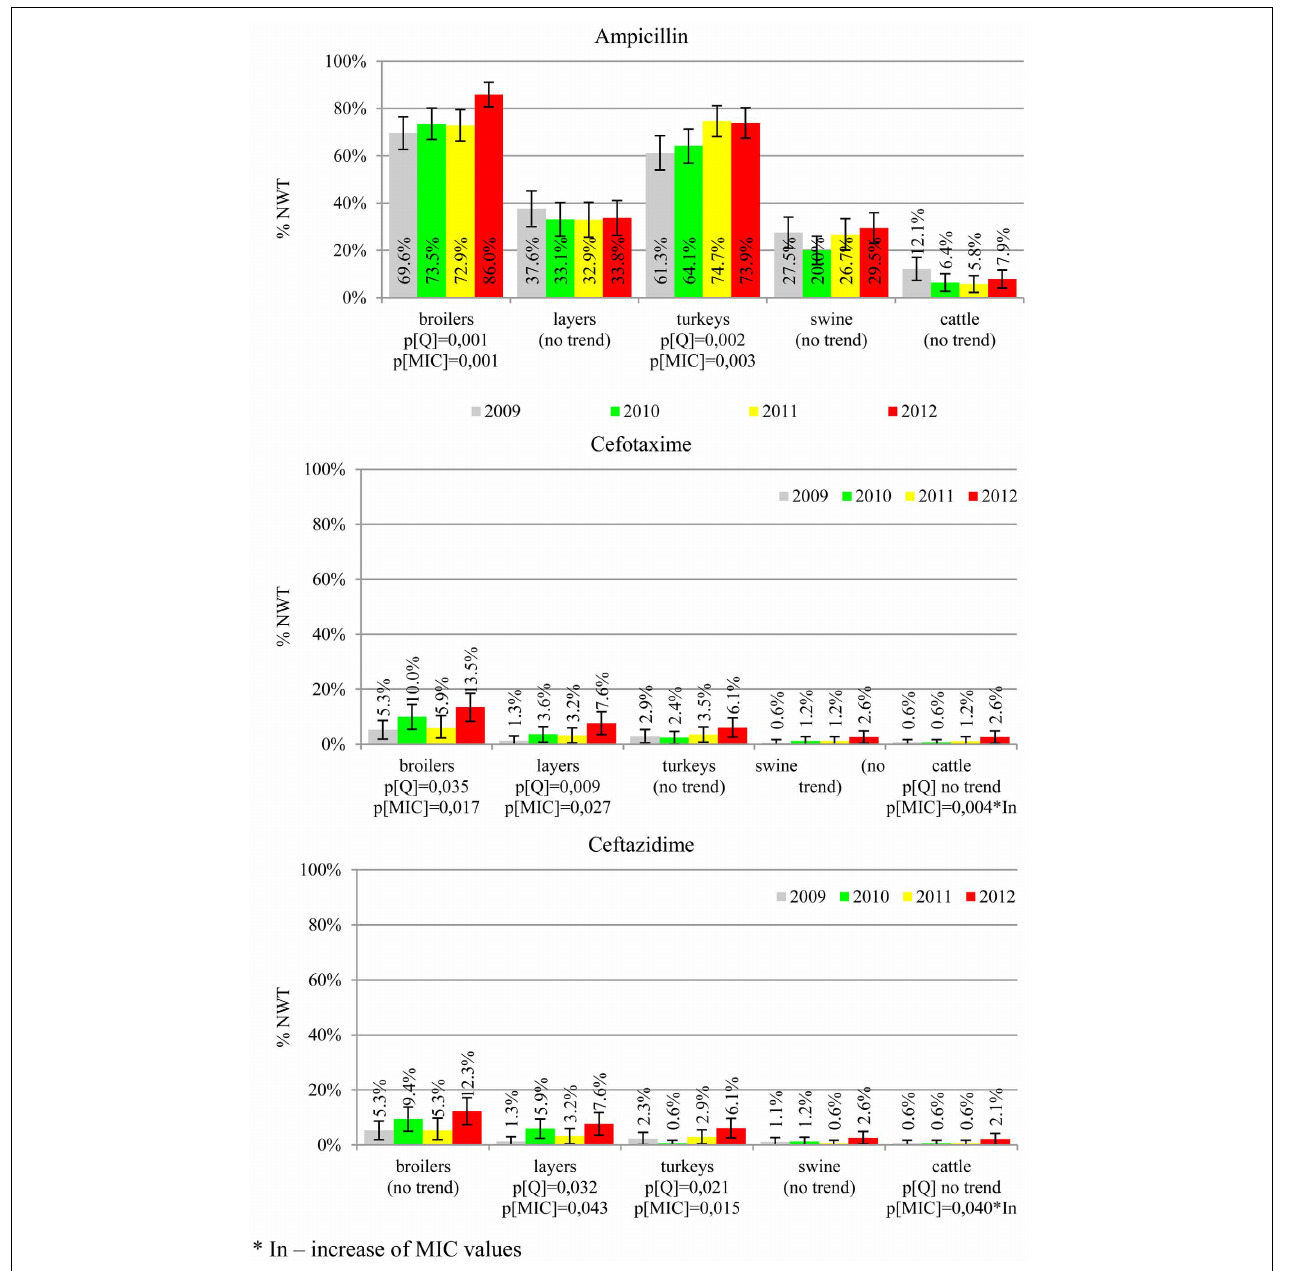
FIGURE 1 | Microbiological resistance to beta-lactams and